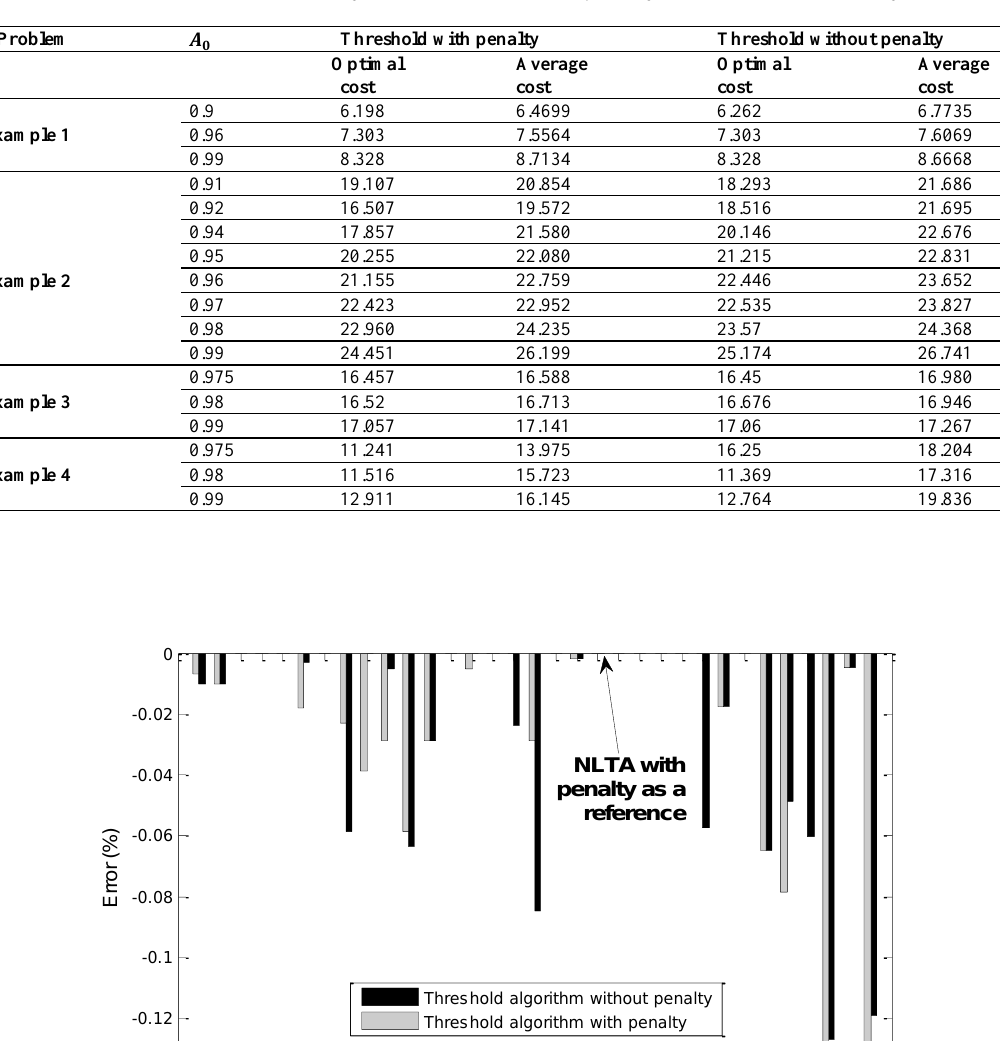
Threshold algorithm without penalty Threshold algorithm with penalty